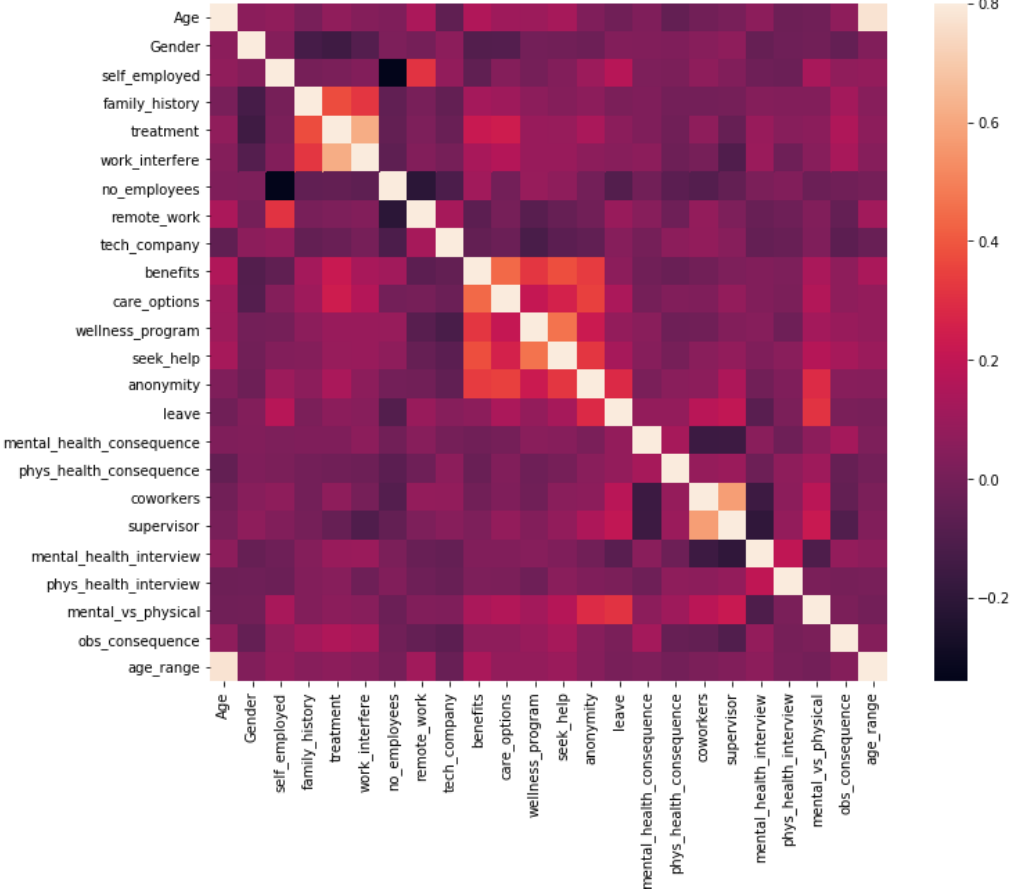
Figure 2: Correlation matrix of MH parameters ParadigmPlus (2022)